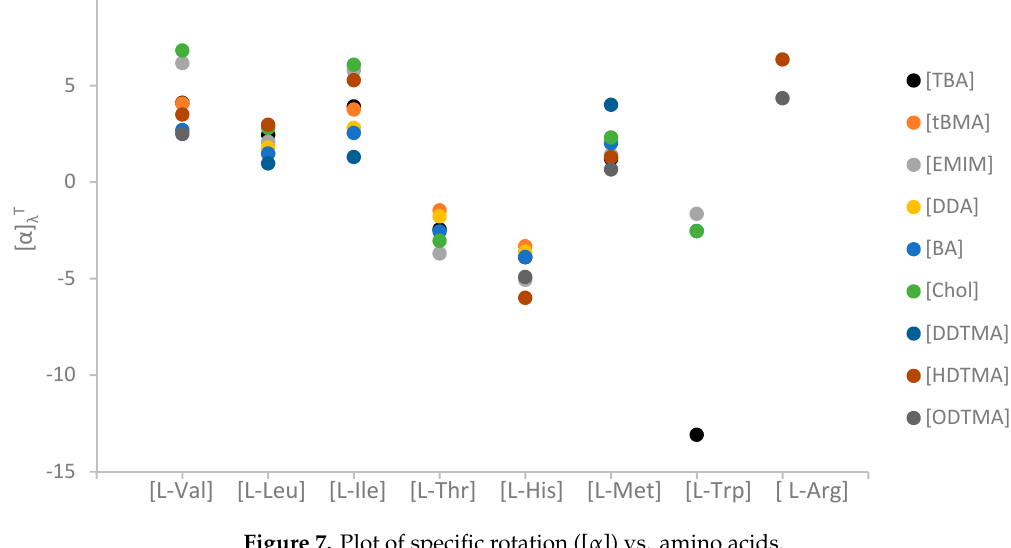
Figure 7. Plot of specific rotation ([ α ]) vs. amino acids.